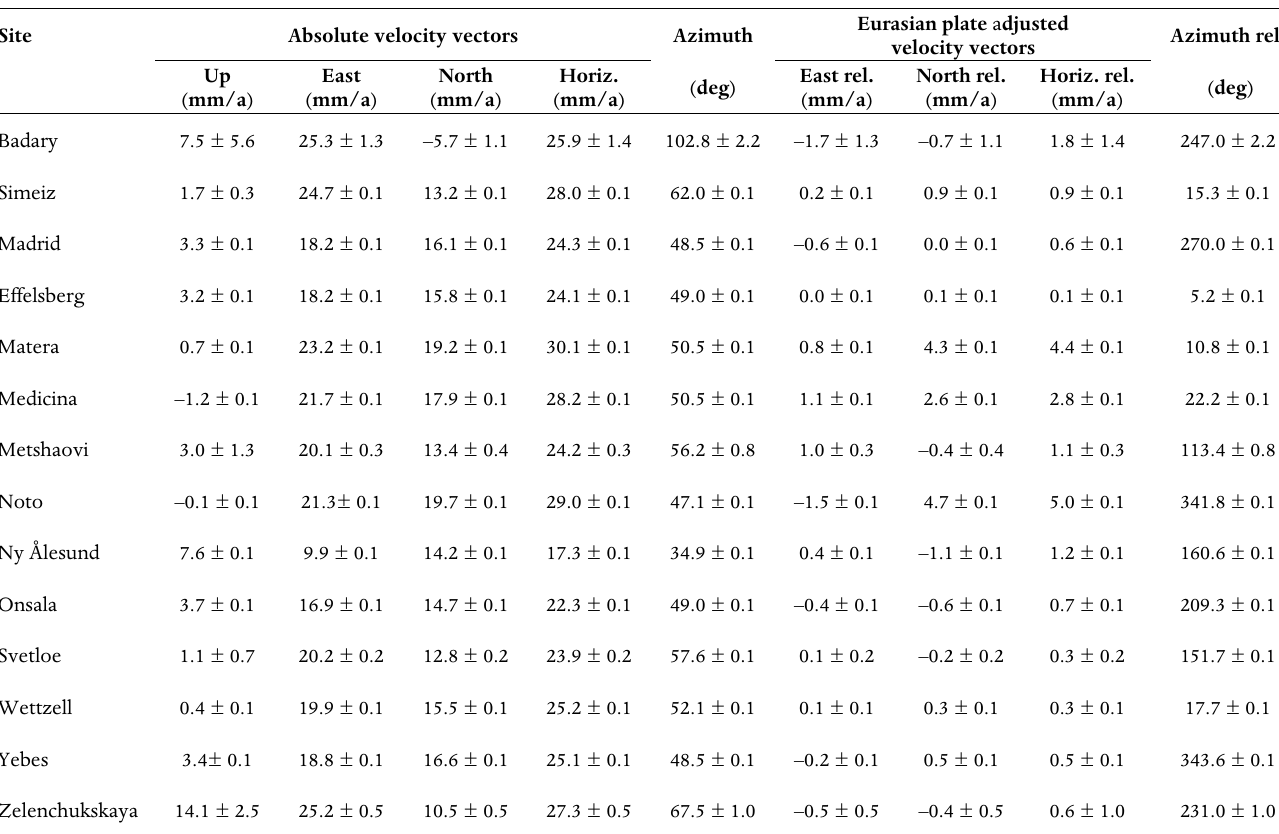
Table 1. Velocities of the European stations expressed in the topocentric frame at each site. Columns 3 and 4: components of the absolute horizontal velocity vector, for which the magnitude is in column 5 and the direction in column 6. Columns 7-10: analogous to previous quantities but with the rigid rotation of the Eurasian plate subtracted. Column 2 and columns 9 and 10: data used in Figures 4 and 3,